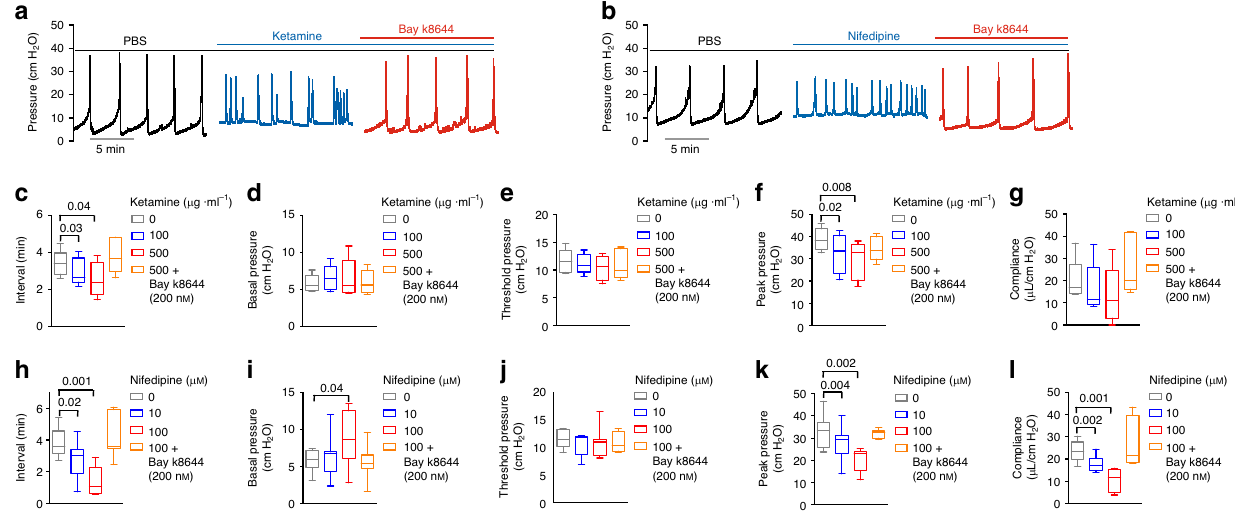
Fig. 10 Ketamine and nifedipine regulated mouse urodynamics resembling ketamine cystitis in humans. a , b Representative CMG traces of ketamine cystitis-like voiding phenotypes induced by intravesical ketamine ( a 100, 500 µ g ml − 1 ) and nifedipine ( b 10, 100 µ M) are reversed by Bay k8644 infusion (200 nM). Summarized CMG data ( c – l n = 5 mice for ketamine group and n = 7 mice for nifedipine group) show that decreased voiding interval ( c , h ), peak pressure ( f , k ), and compliance ( g , l ), were each rescued by Bay k8644 infusion. Data are shown as box and whiskers, center line is the median of the data set, box represents 75% of the data, and bars indicates whiskers from minimum to maximum. Data were analysed by paired two tail Student ’ s t -tests. P < 0.05 is considered to be signi fi cant and P values are given above the bars. Source data are provided as a Source Data fi